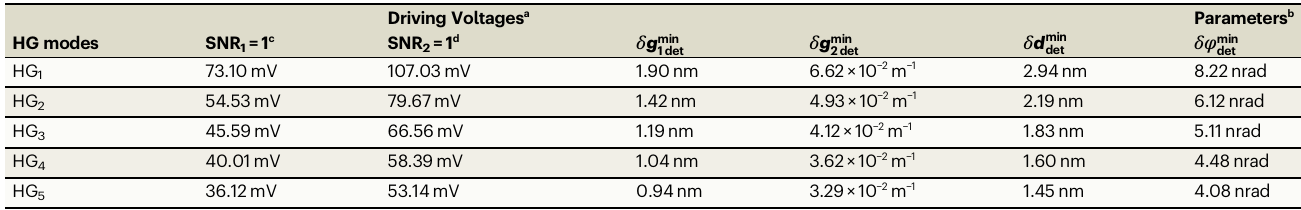
Table 1 | Experimental